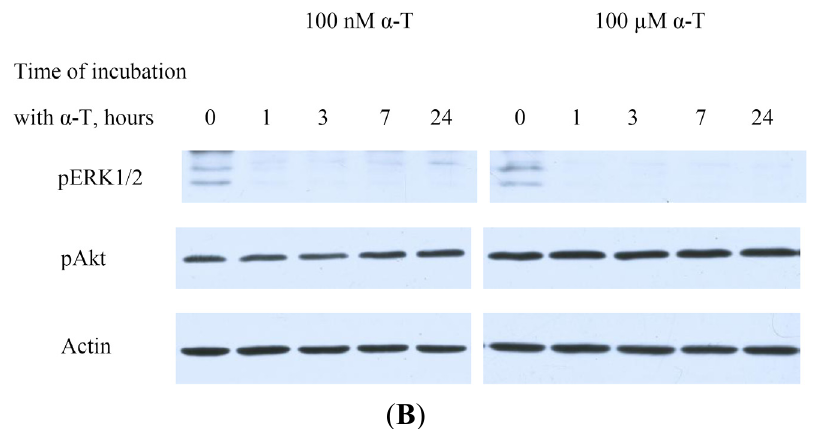
O for 20 min on ERK 1/2, Akt, pERK 1/2 2 2